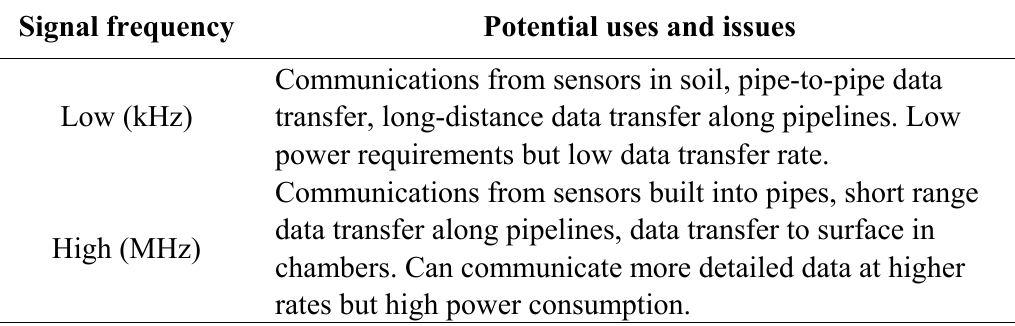
Table 1. Signal frequencies and their potential uses [29].